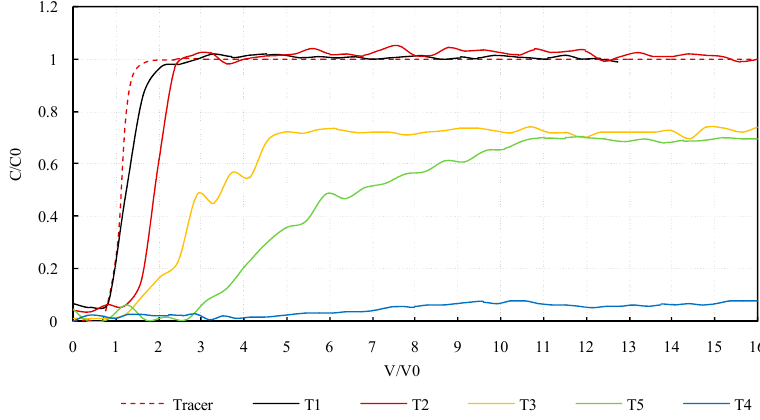
Figure 4. Experimental breakthrough curves for colloidal silica under different hydrogeochemical conditions.